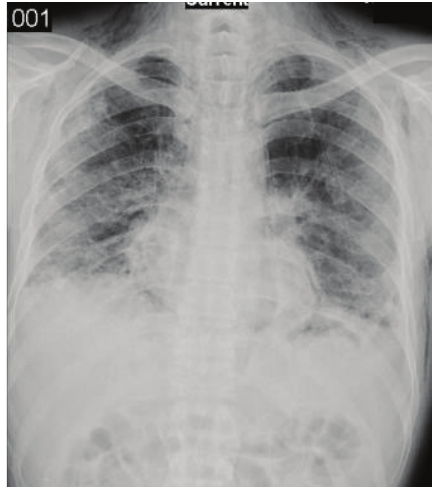
Figure3:Chestradiographshowingbilateralopacities,pneumome- diastinum, and subcutaneous